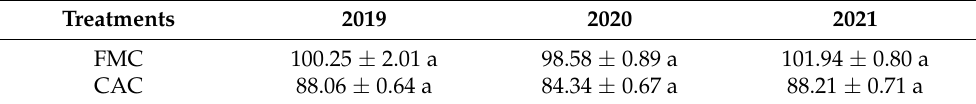
Table 1. Cane yields between FMC and CAC treatments (t ha − 1